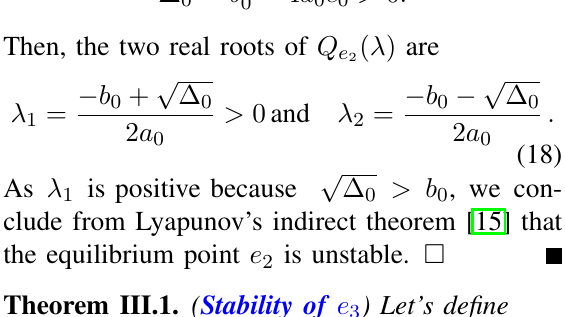
TABLE II: Some admissible parameters with conditions R 1 , R 2 , R 3 , R 4